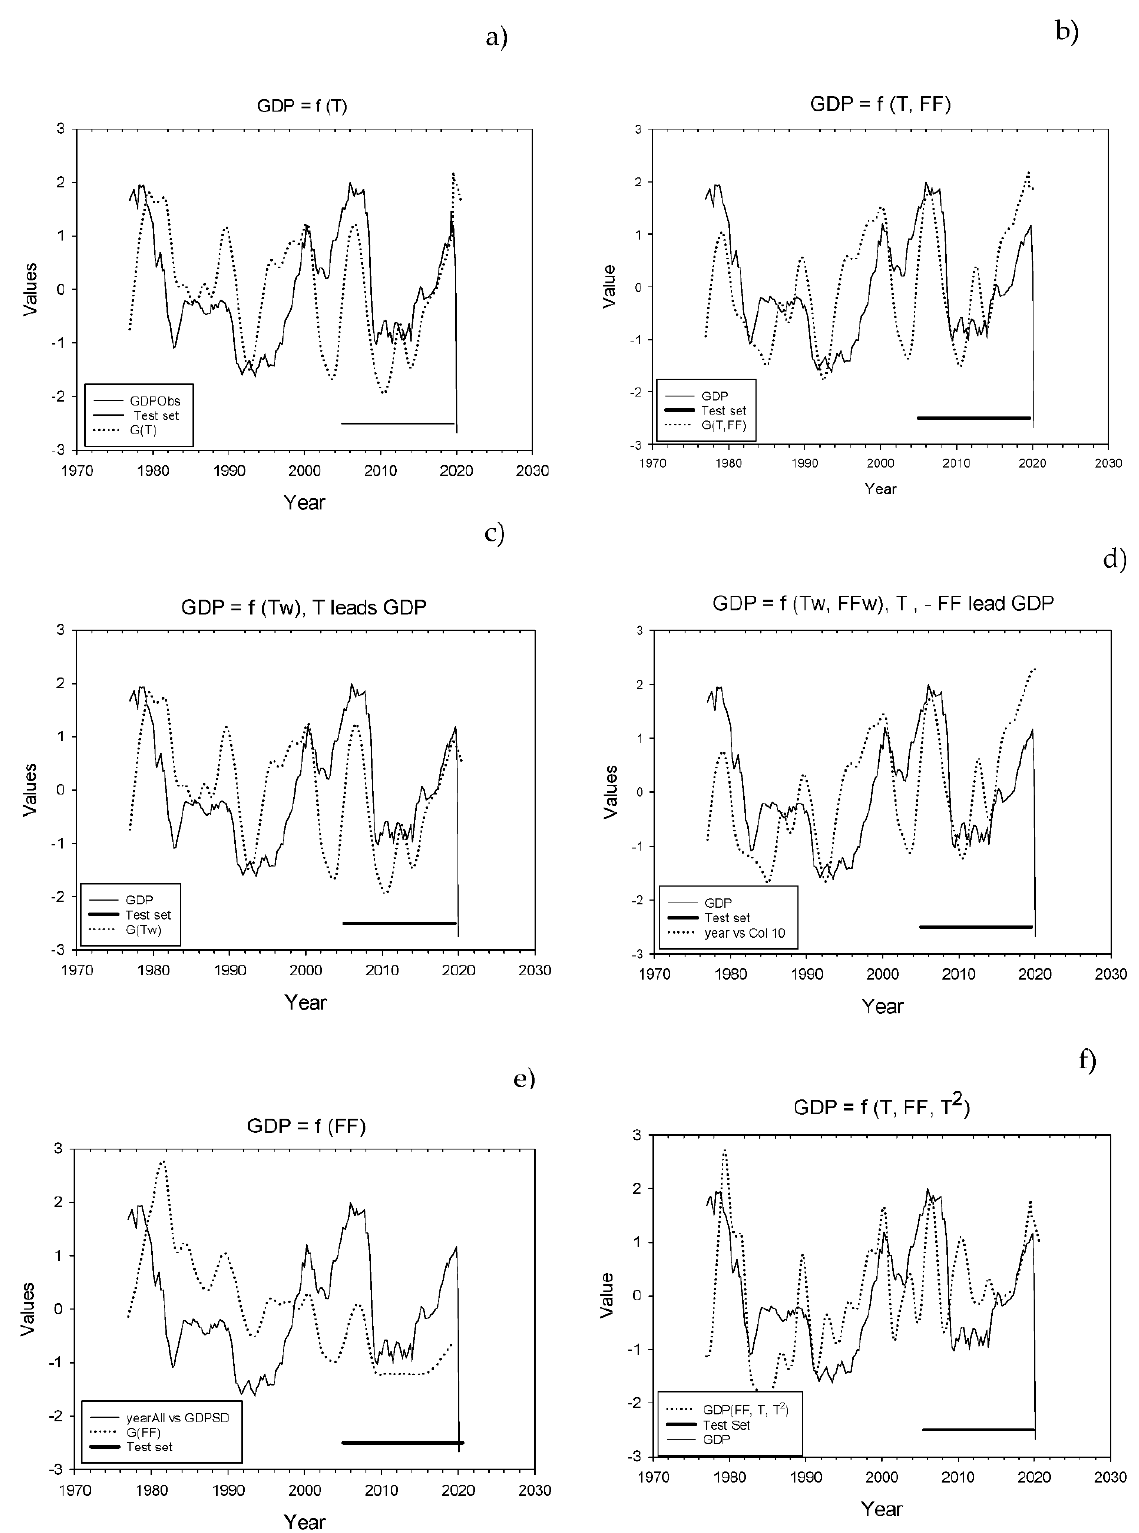
Figure 2. Comparison of Observed GDP with calculated and normalized GDP under different restrictions on the variables in the learning set. ( a ) GDP = f(T). ( b ) GDP = f(T, FF). ( c ) GDP = f(Tw), Tw indicate that both time series are restricted to periods when T is leading GDP. ( d ) GDP= f(Tw, FFw), Tw and FFw indicate that GDP, T and FF are restricted to time windows where both T and − FF lead GDP. The thick line to the lower right indicates the test set. ( e ) GDP = f(FF). ( f ) GDP = f(T, FF, T 2 ).